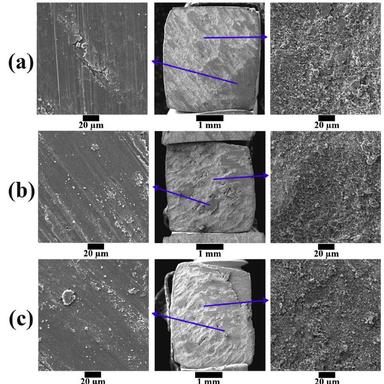
Fractographic features on the worn-out surfaces of processed composite materials with optimum composition after sliding distance of 1000 m: (a) AA6061- 20 wt% TiB2 single composite, (b) AA6061-1 wt% Graphene single composite, and (c) AA6061-1 wt% Graphene-20 wt% TiB2 hybrid nanocomposite.